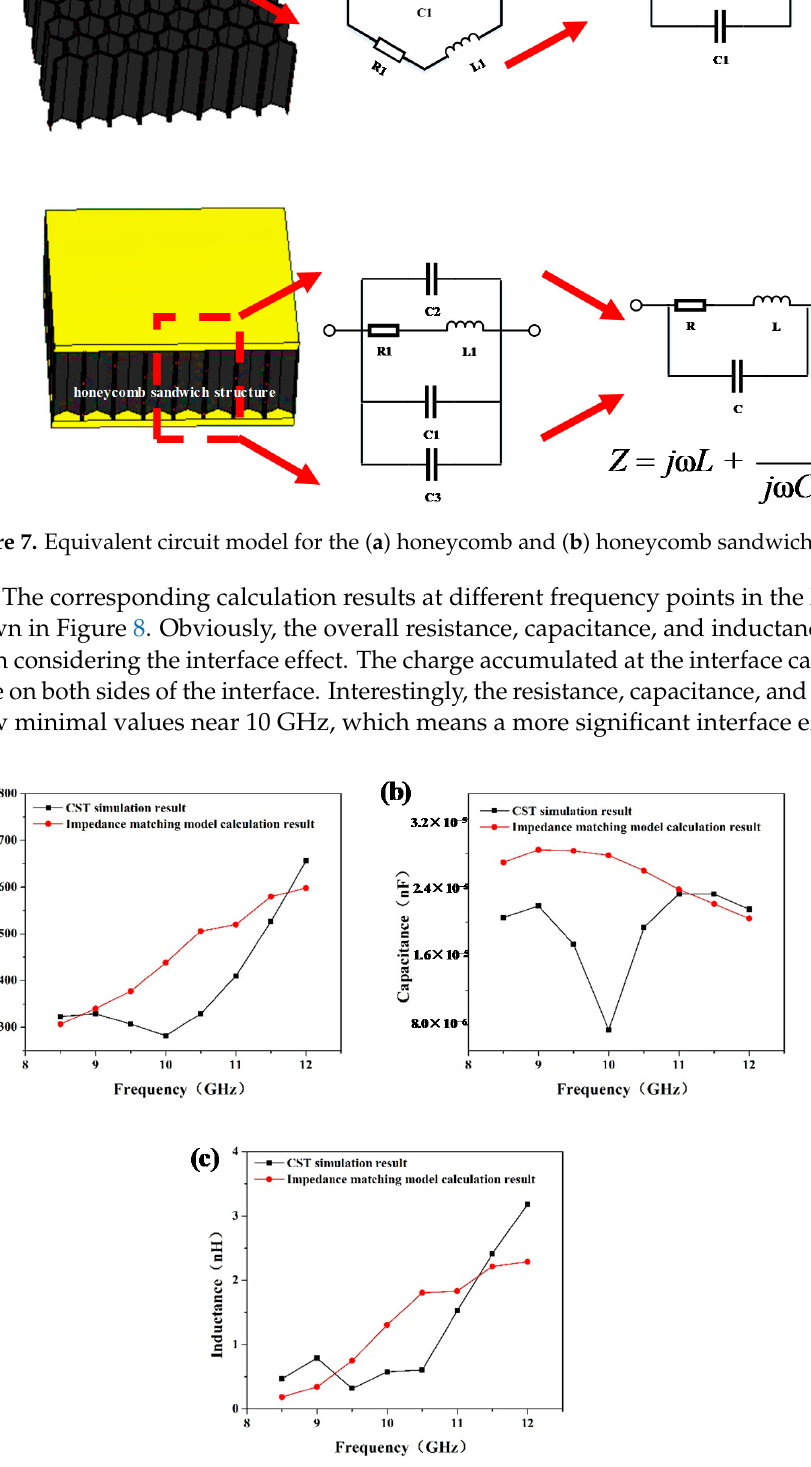
Figure 8. Resistance ( a ), capacitance ( b ), and inductance ( c ) obtained from the CST simulation and impedance matching model.